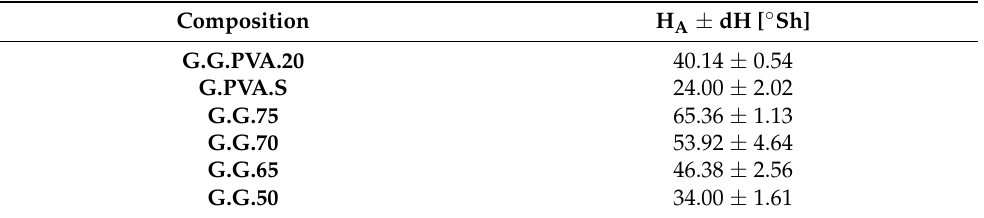
Table 3. Shore A hardness measurements with standard